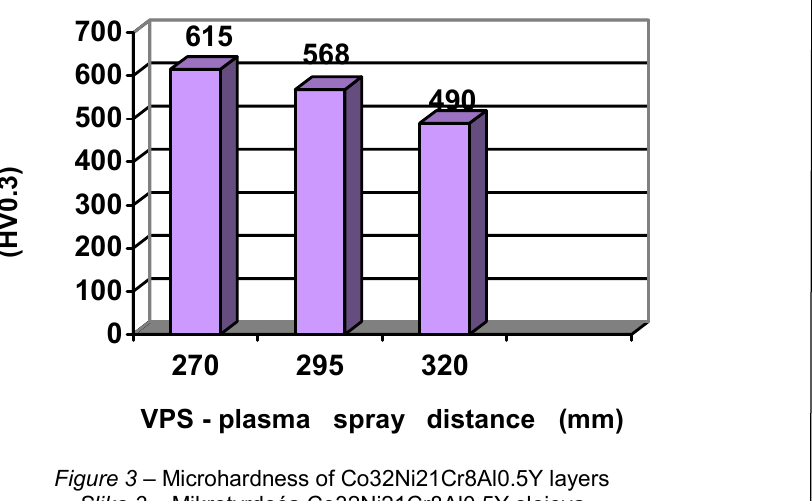
Figure 3 – Microhardness of Co32Ni21Cr8Al0.5Y